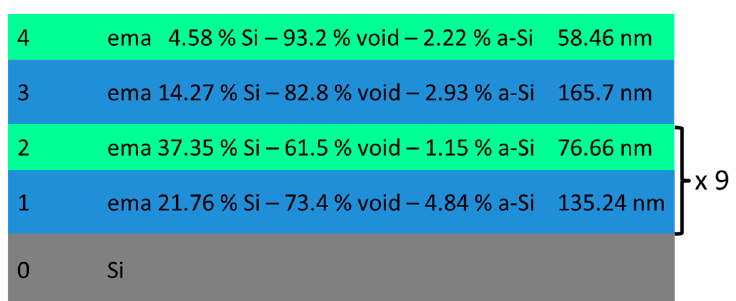
Figure A1. Model of the DBR structure with band gap centered at about 650 nm.